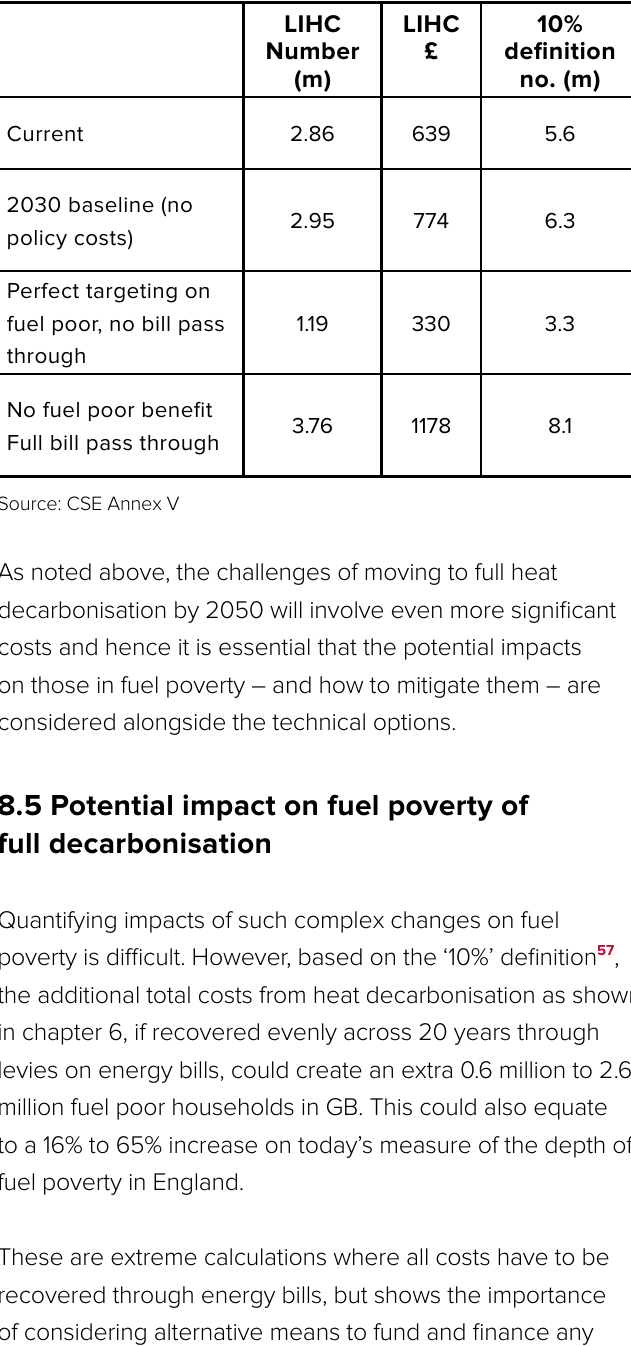
Table: Impacts on UK fuel poverty in 2030 of